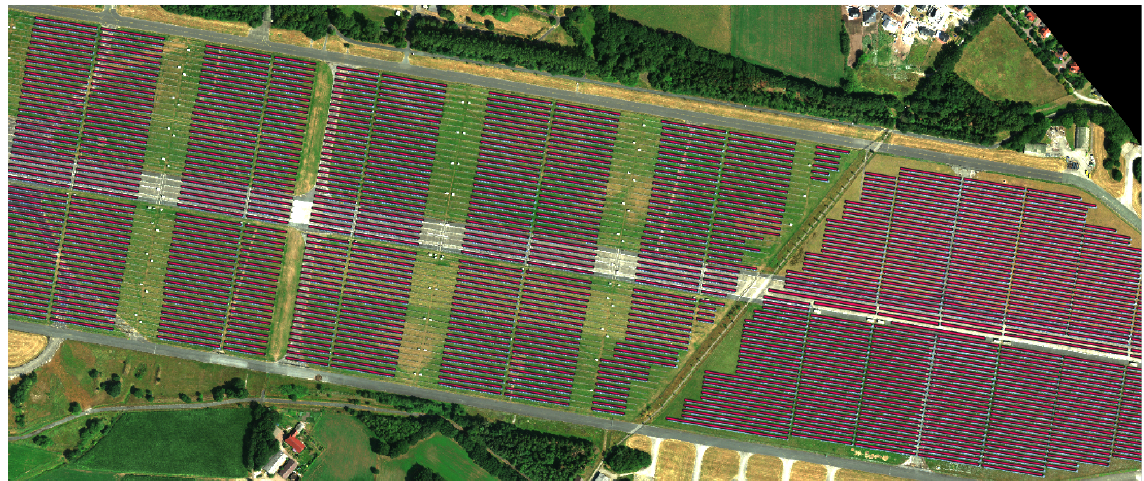
Figure 1: Detail of ground truth in vectorial format for solar panels (red), overlaid on HySpex true color composite.